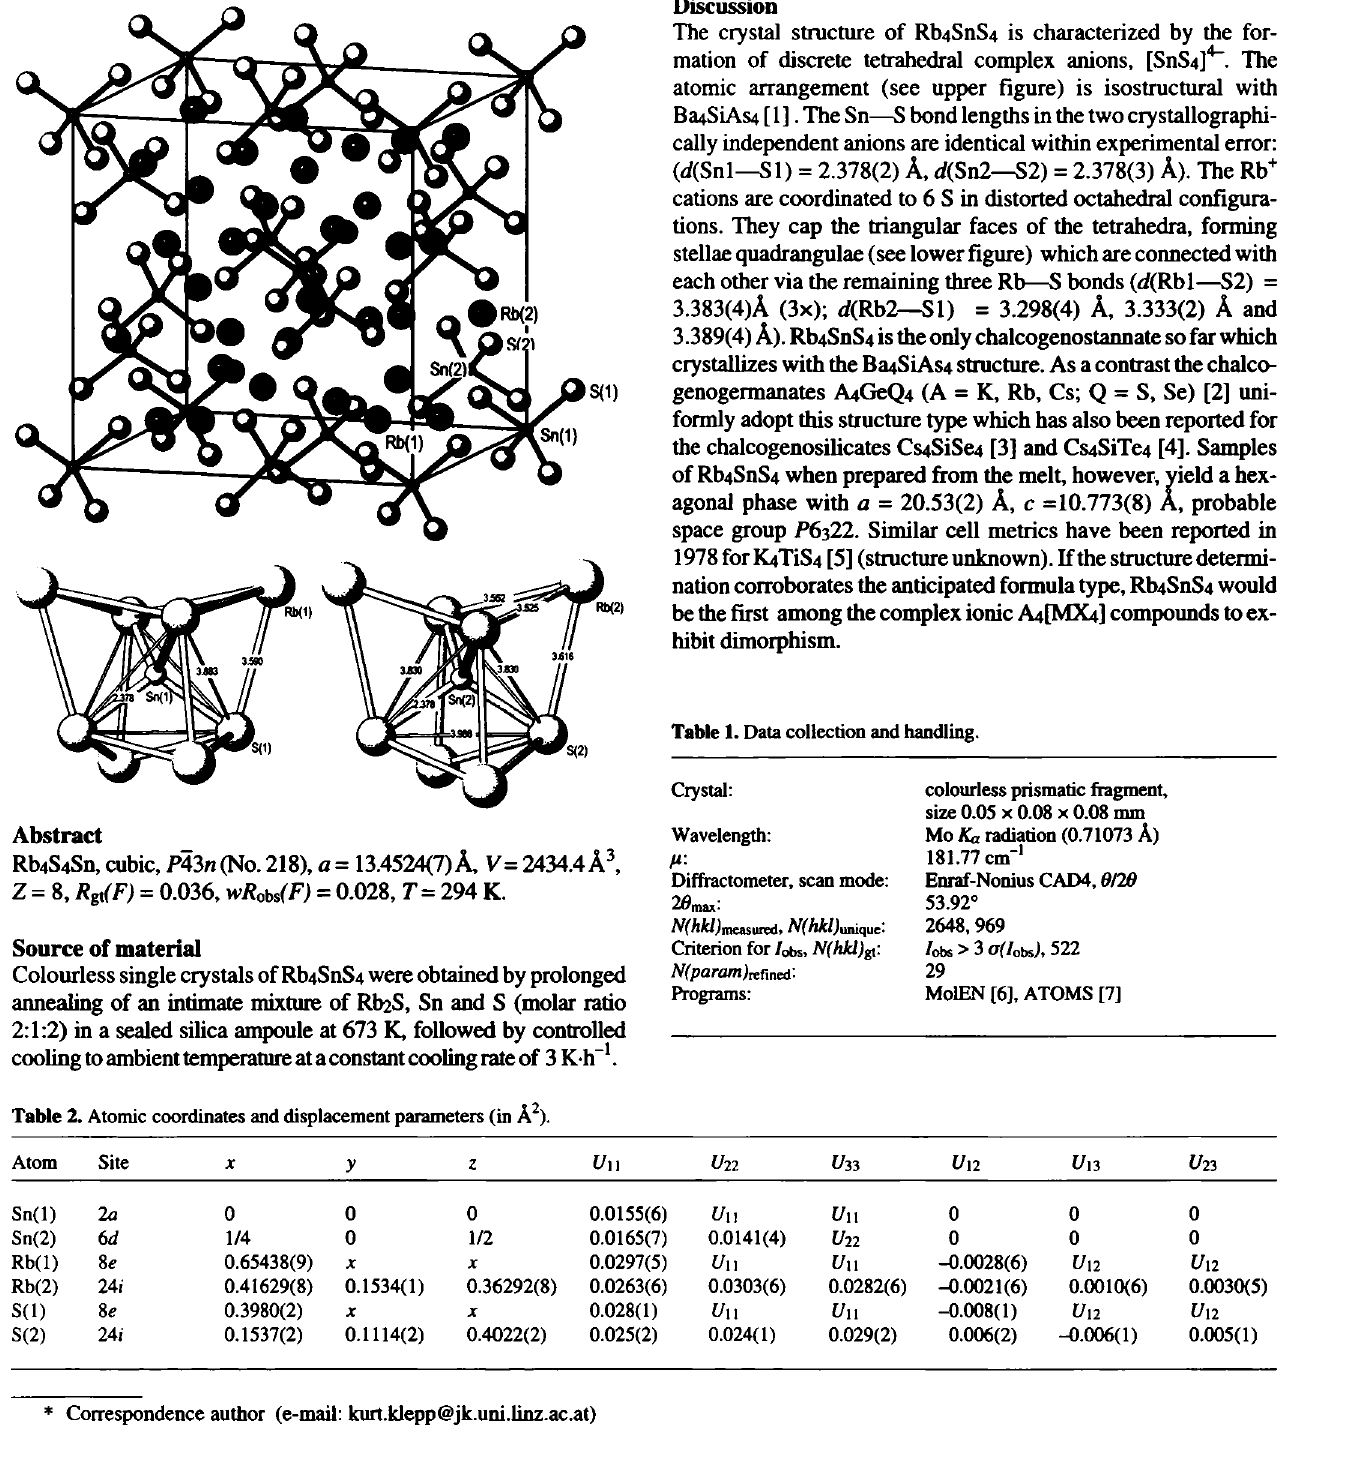
Table 2. Atomic coordinates and displacement parameters (in Â 2